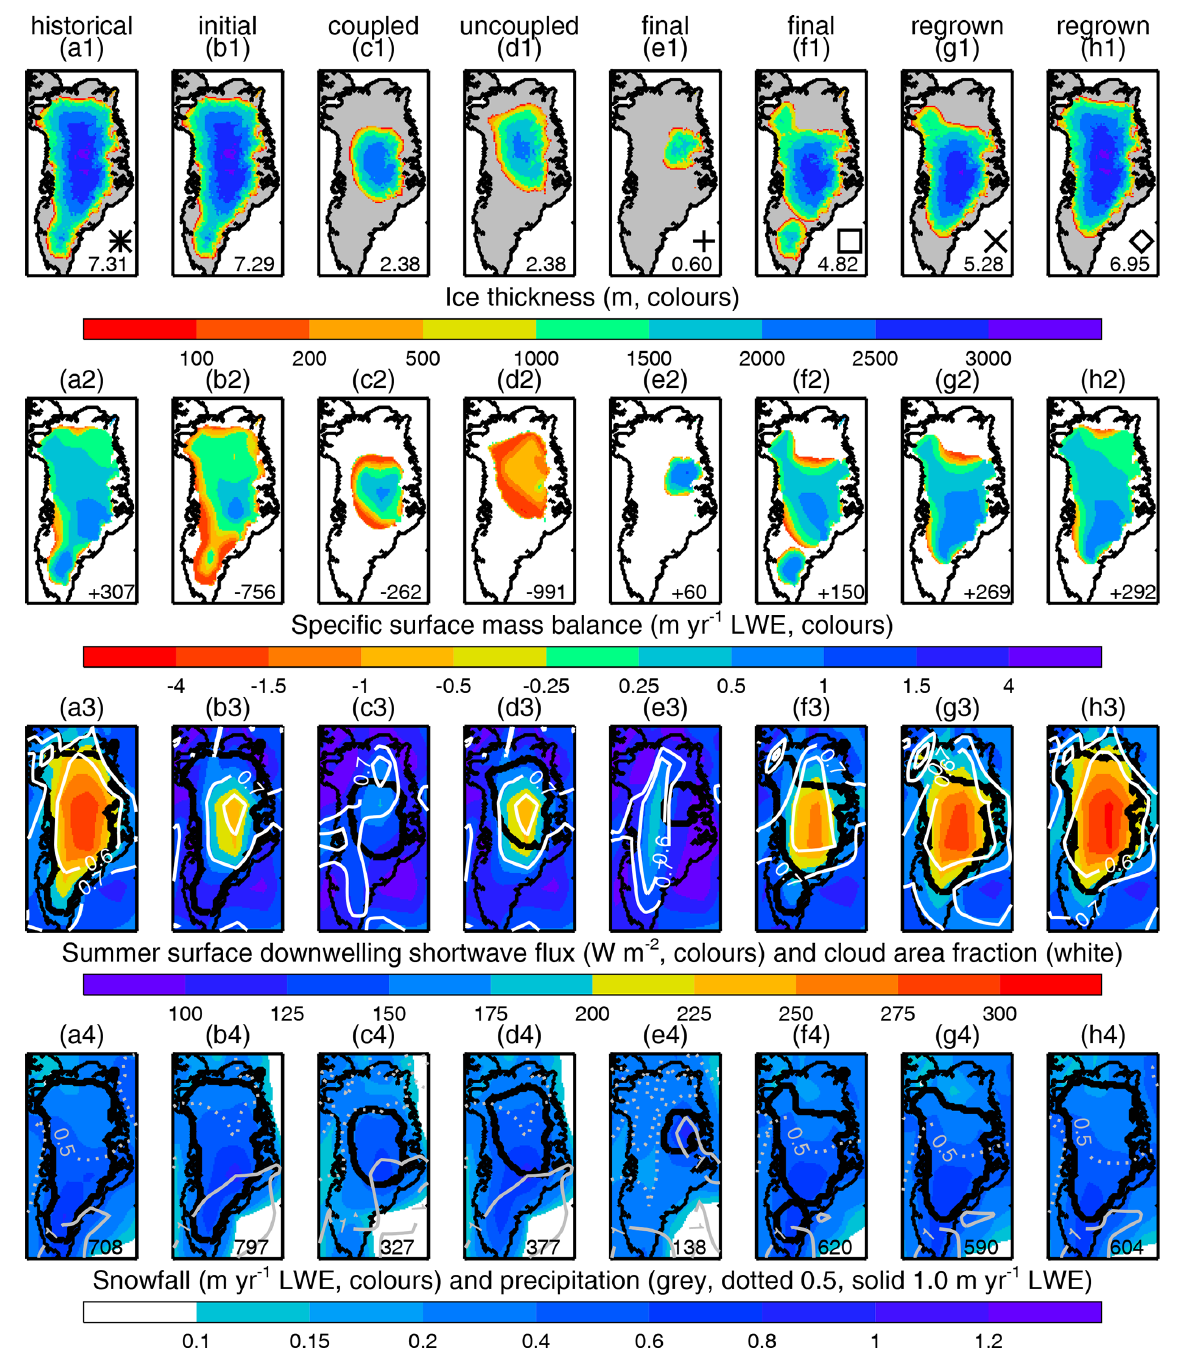
Figure 3. Illustrative states of the ice sheet, all from coupled FAMOUS–ice–Glimmer experiments except for column (d) , as follows: (a) initial state with HadGEM2-ES historical climate and low albedo; (b) initial state with HadGEM2-ES abrupt4xCO2 climate and low albedo; (c) transient state from the experiment of (b) ; (d) transient state of uncoupled Glimmer with the climate and 3D SMB of (b) ; (e) final state with CanESM2 abrupt4xCO2 climate and low albedo; (f) final state with MIROC5 RCP4.5 climate and medium albedo; (g, h) final states with MIROC5 historical climate and low albedo, regrown from transient states with M = 3 . 83m SLE and M = 4 . 03m SLE, respectively, in the experiment of (b) . The quantity shown in each row in colours and by contour lines in rows 3–4 is stated above its colour bar. Row 1 is an instantaneous state; rows 2–4 are time means of 30 FAMOUS–ice years, equivalent to 300 FiG years. The ice sheet edge is shown by a thick black line in rows 2–4. The numbers in the bottom-right corner are ice sheet mass in m SLE in row 1, ice sheet area-integral SMB in Gtyr − 1 row 2 and ice sheet area-integral snowfall in Gtyr − 1 row 4. The symbols in row 1 indicate steady-state configurations by the key of Fig.